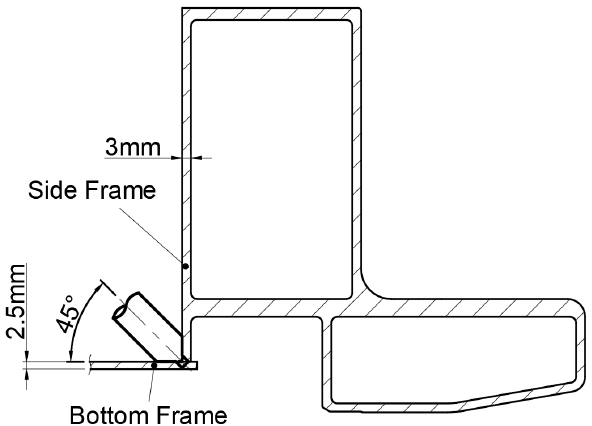
Figure 3. Application type of fillet joint FSW.